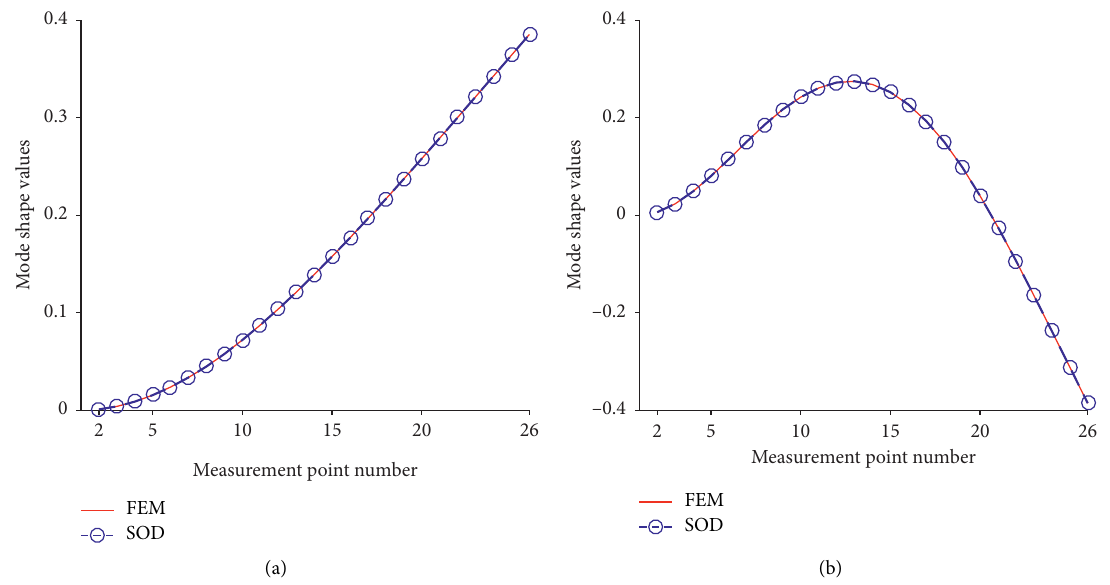
Figure 10: Mode shapes of a cantilever beam with double damage (0.5% for the noise level). (a) First mode. (b) Second mode.